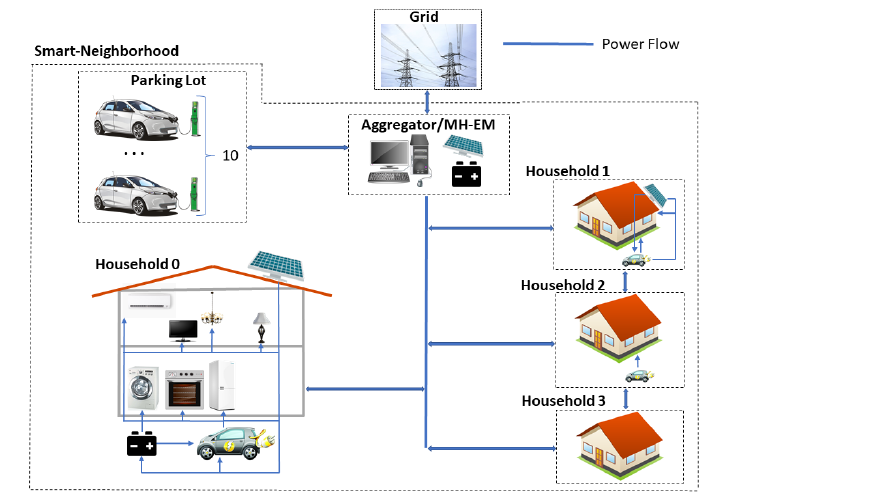
Figure 3. Case study considered in the